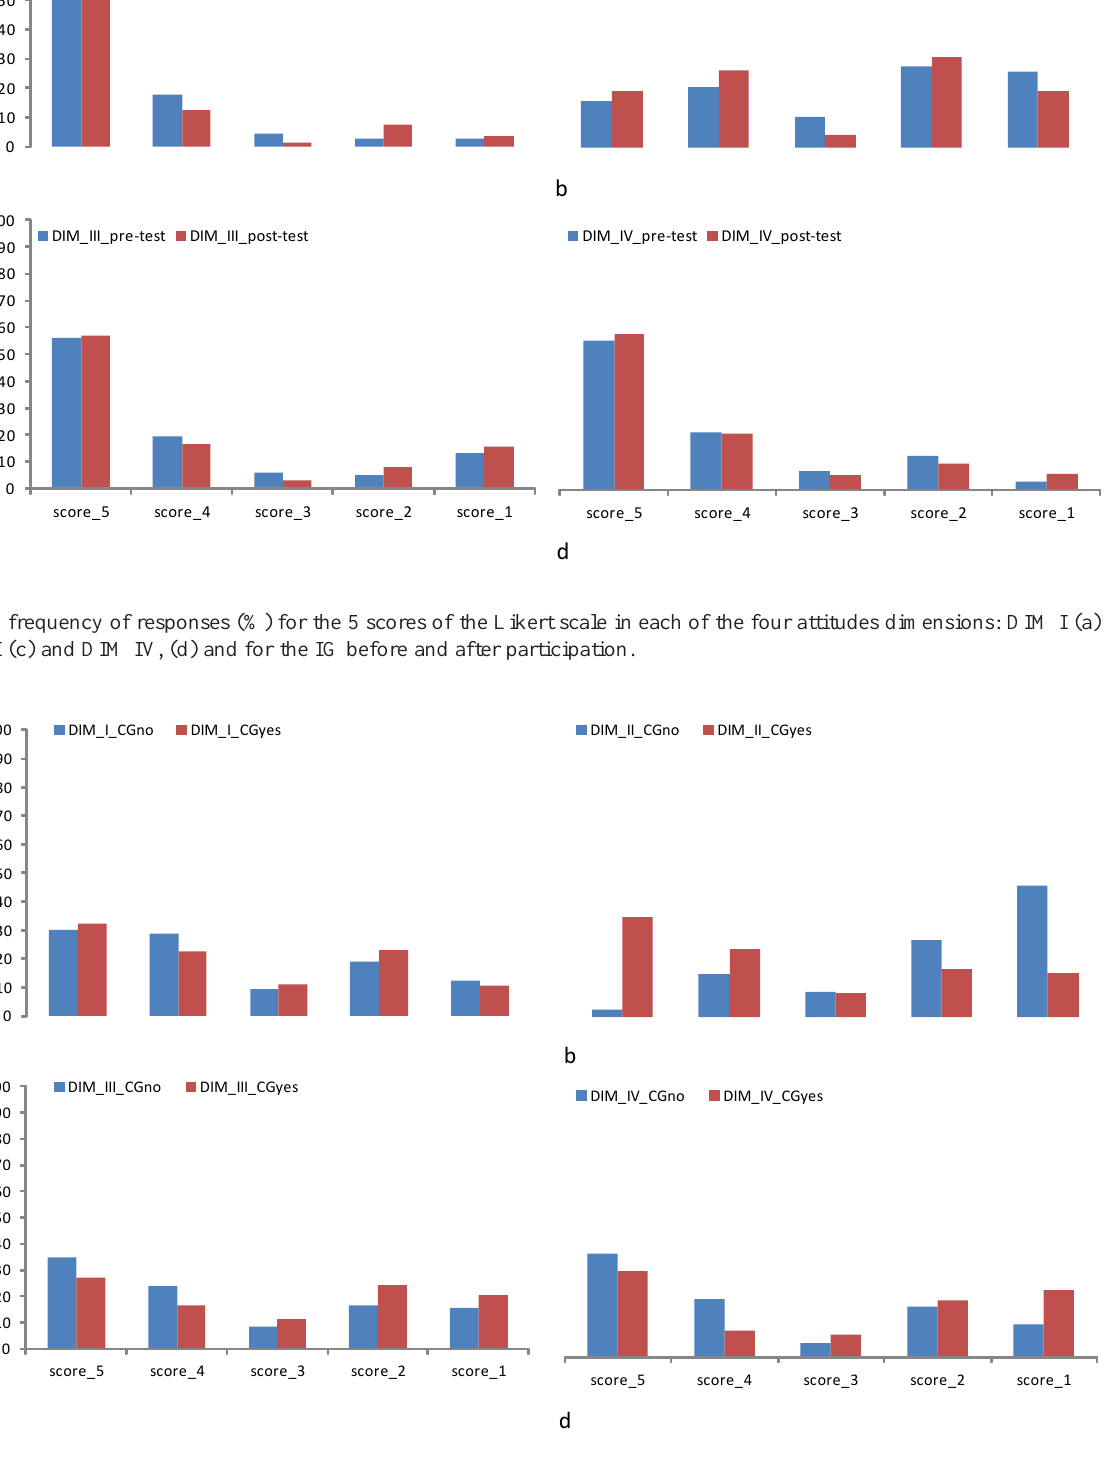
Figure 6. CGno and CGyes frequency of responses (%) for the 5 scores of the Likert scale in each of the four attitude dimensions: DIM I (a), DIM II (b), DIM III (c) and DIM IV, and (d), for the IG before and after